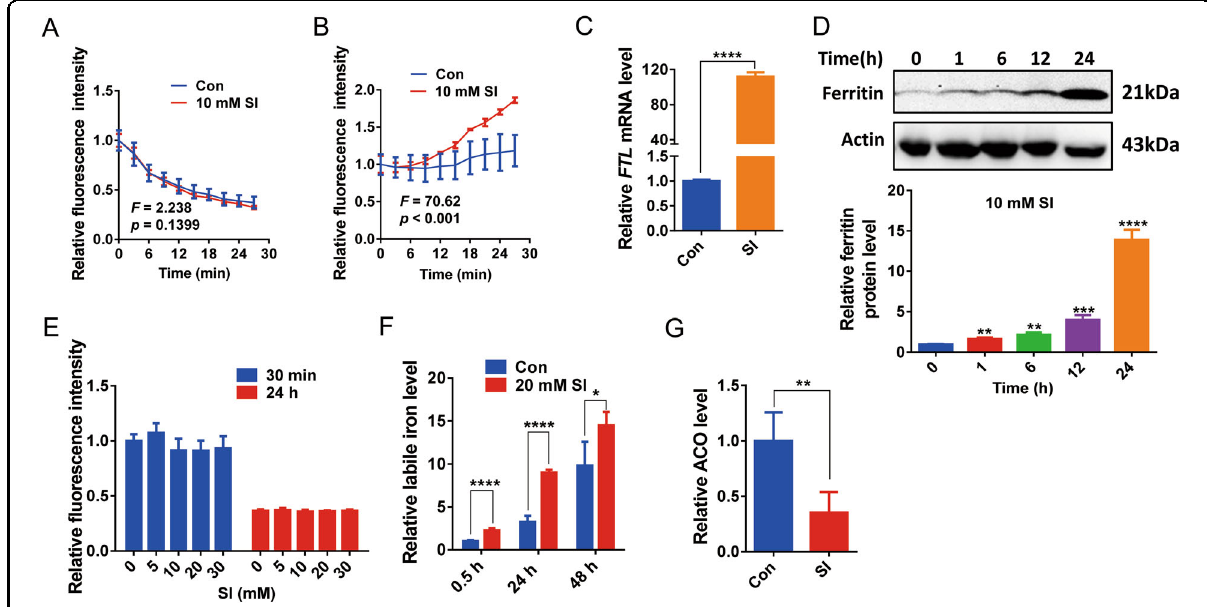
Fig. 6 SI induces the increase of labile iron by promoting the release of sequestered iron in ARPE-19 cells. A , B Ferrous iron in fl ux ( A ) or ef fl ux ( B ) in SI-treated ARPE-19 cells was indicated by the quenching and reversing of calcein fl uorescence, a marker of the intracellular labile iron level. The relative fl uorescence intensity represented the ratios of the fl uorescence intensity of the samples at the indicated time relative to its initial fl uorescence intensity. F and P values were calculated by ordinary two-way ANOVA ( n = 4). C Quantitative real-time PCR analysis of ferritin (ferritin light chain, FTL) mRNA levels in ARPE-19 cells treated with or without 10 mM NaIO 3 for 24 h ( n = 3). D Upper panel: Western blots of ferritin in ARPE- 19 cells incubated with 10 mM NaIO 3 for the indicated time. Lower panel: the quanti fi cations of three repeats from the upper panel ( n = 3). E SI did not promote the release of free iron in ferritin from the horse spleen. Totally, 0.16 mg/ml ferritin from the horse spleen was treated with NaIO 3 at the indicated concentrations for 30 min or 24 h and the level of free iron in ferritin solution was determined by calcein fl uorescence quenching ( n = 5). F SI promoted the release of free iron in the ARPE-19 cell lysate. ARPE-19 cell lysate was treated with 20 mM NaIO 3 for 30 min, 24 h, or 48 h and the level of free iron in ferritin solution was determined by calcein fl uorescence quenching ( n = 4). G The activity of aconitase (ACO) in the ARPE-19 cell- free lysate treated with or without 10 mM NaIO 3 for 10 min ( n =